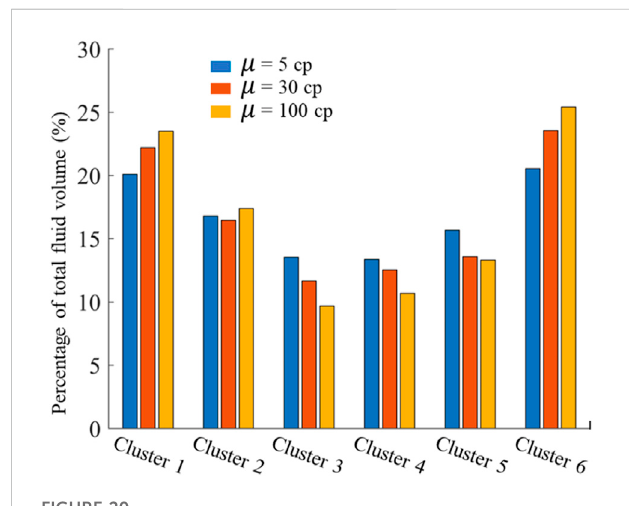
FIGURE 20 The total fl uid volume distribution of each cluster for three cases with different fracturing fl uid